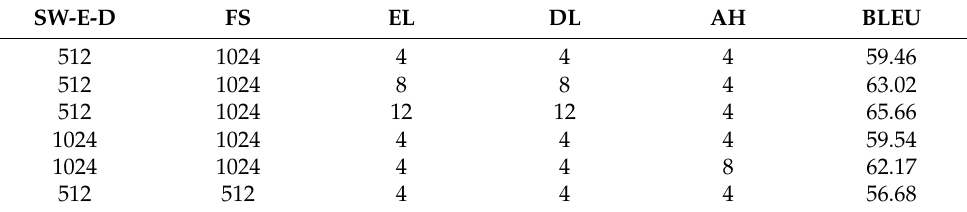
Table 2. Results of the Transformer-Based NMT Subword Model on PMM–MAG corpus for MAG– MSA translation task, where SW-E-D is the Subword embedding dimension, FS is the filter size, EL is the encoder’s layers, DL is the decoder’s layers and AH is the attention heads number. SW-E-D